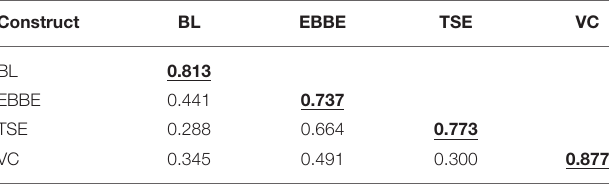
TABLE 1 | Discriminant validity (Fornell-Larker-1981 Criteria).